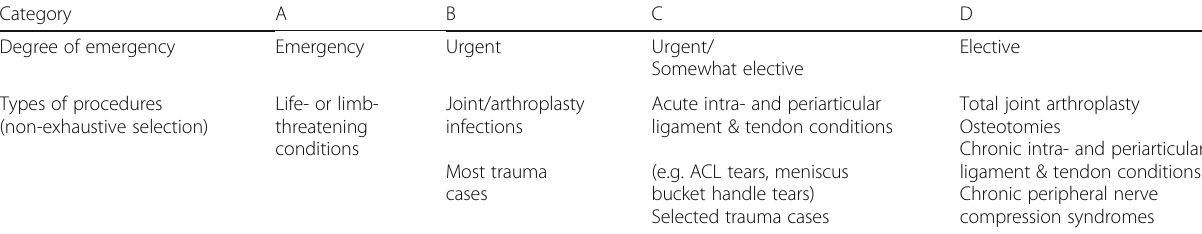
Table 1 Adapted from AAOS guidelines for elective surgery [5]